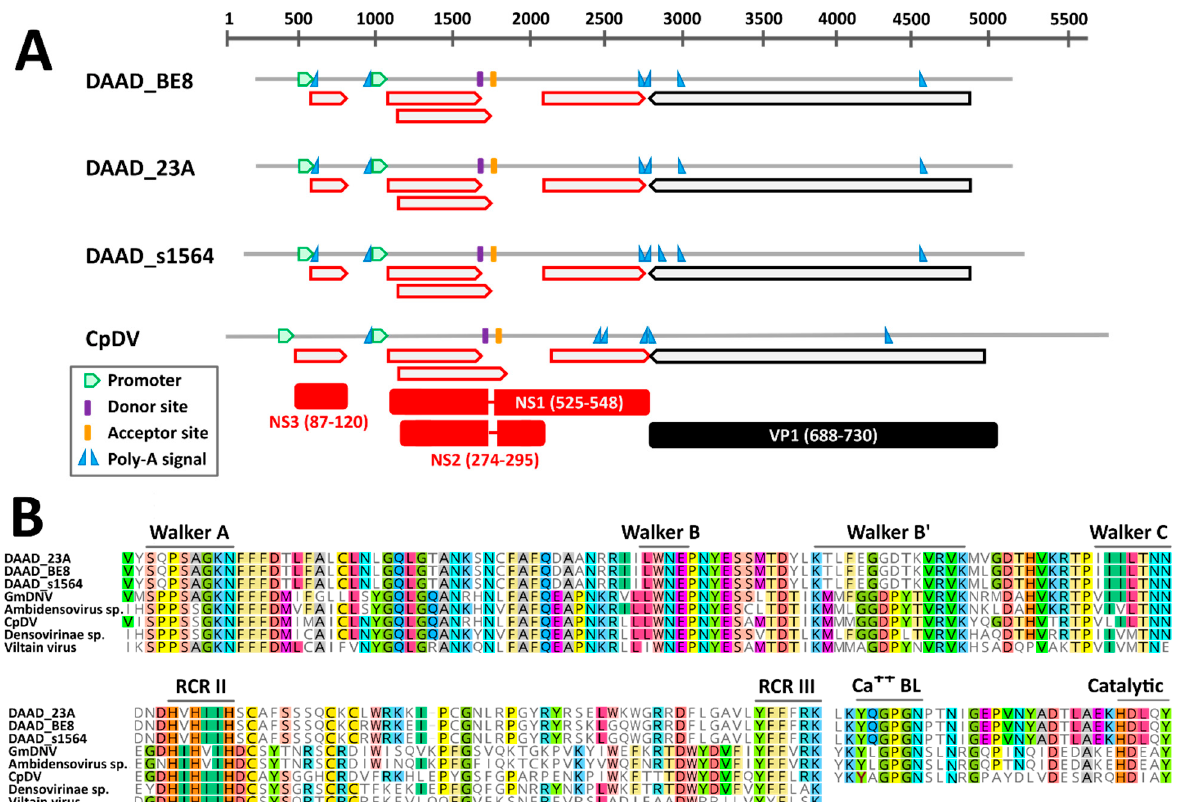
Figure 3. Genomic features of the novel duck-associated ambidensoviruses (DAAD) compared to that of Culex pipiens densovirus (CpDV). ( A ) Schematic genome representations with in silico predicted ORFs (red for NS and black for VP proteins), splicing donor and acceptor sites, poly-adenylation signals, and promoter (as indicated by the legend). Hypothetical proteins (with respective protein sizes) generated after mRNA splicing are shown at the bottom. ( B ) Conserved rolling circle replication (RCR) and Walker motifs typical of parvoviral SF3 helicases and phospholipase A 2 (Ca ++ BL: calcium binding loop; Catalytic: catalytic site) motifs typical of parvoviral VP1. GmDNV: Galleria mellonella densovirus.